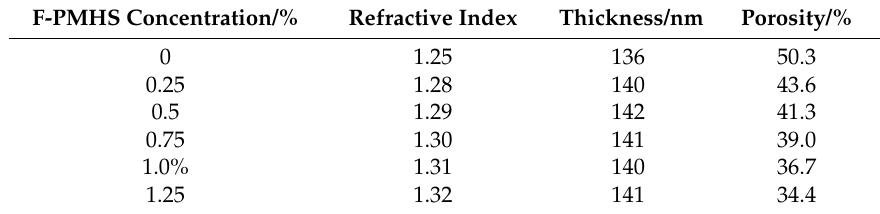
Table 1. Change in refractive index, thickness and porosity as a function of F-PMHS concentration. F-PMHS Concentration/% Refractive Index Thickness/nm Porosity/%